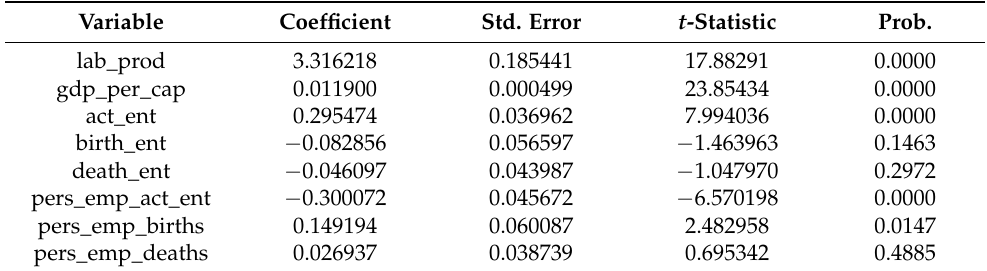
Table 7. The estimators of the regression